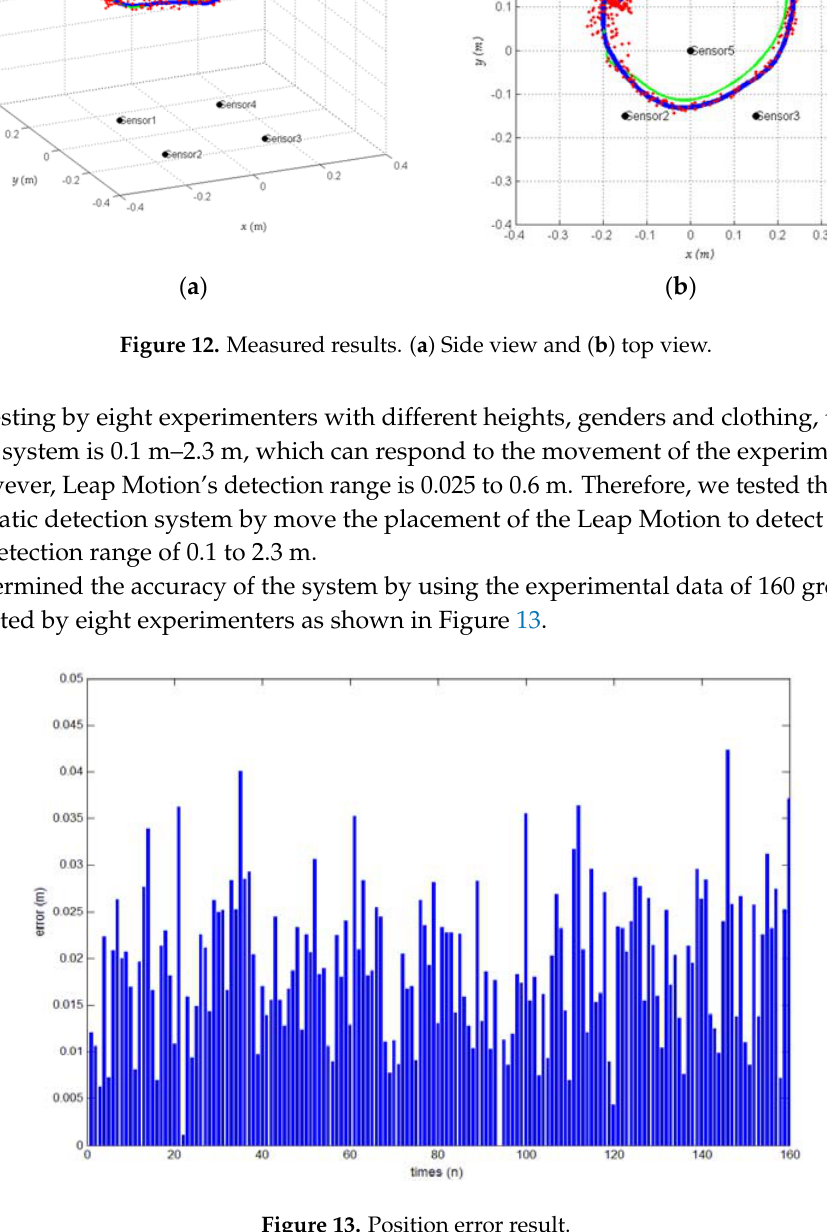
Figure 11. Experimental scene.